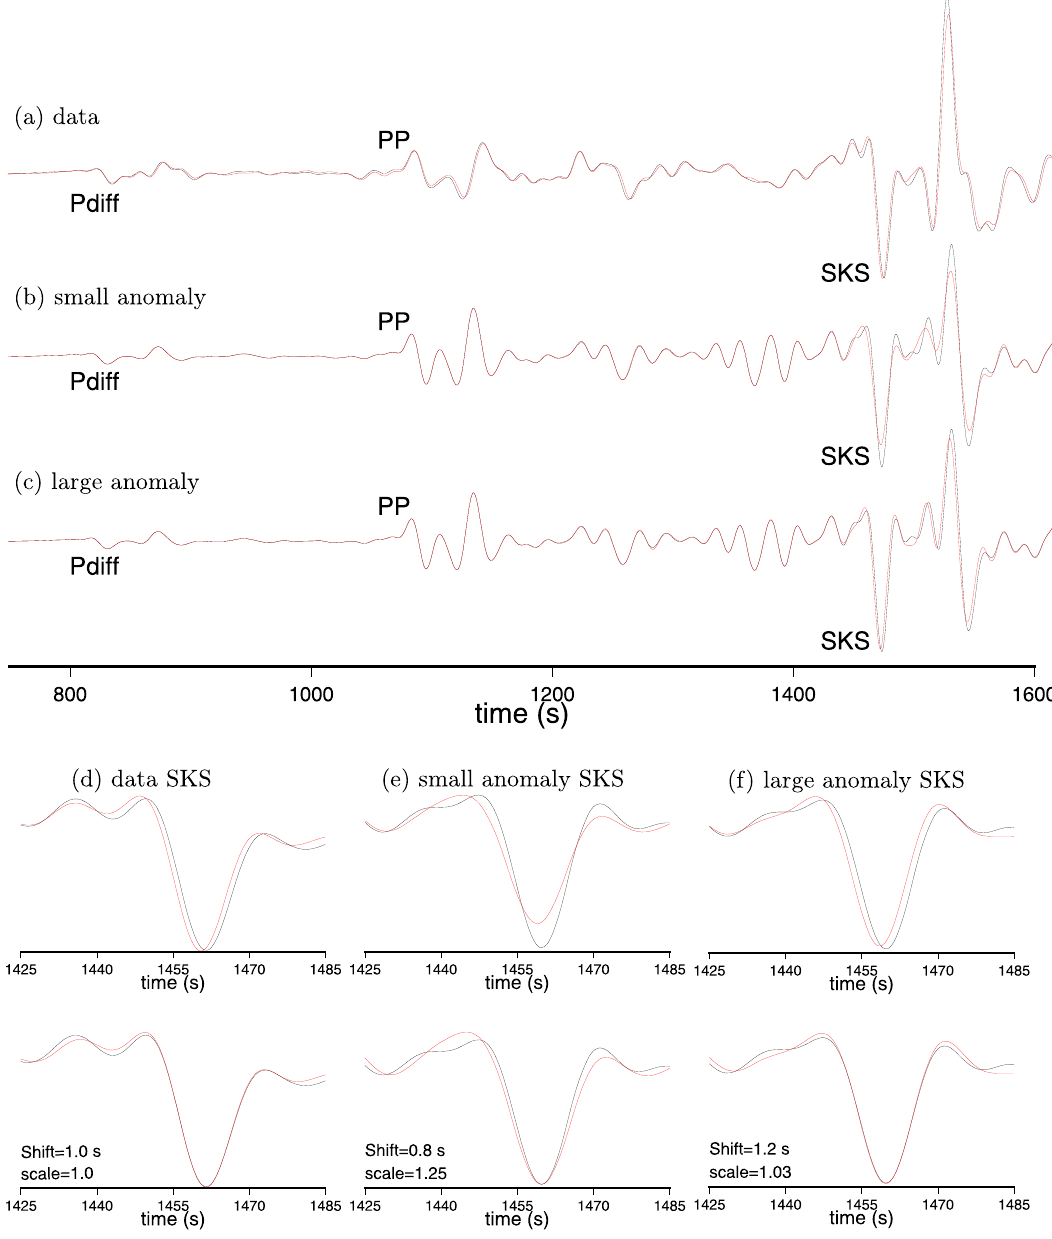
Fig. 6 SPECFEM seismograms calculated for different size core anomalies. a Observed seismograms at station ULN. A longer section of the original seismograms are plotted in Fig. S5. The SKS wave travels faster at the time of the second earthquake (red line). b and c are synthetic seismograms calculated for a small and a large anomaly in the outer core. d – f are zoom-in views of the SKS waves. The small anomaly has a radius of 6 ∘ and P-wavespeed increase of 4%; and the large anomaly has a radius of 12 ∘ and P-wavespeed increase of 1.5%, respectively. The locations of the anomalies are plotted in Fig. 5. The reference 1D model is PREM. It is worth noting that the observed data in ( a ) are for two different earthquakes with different focal depths, and therefore their depth phases have different arrivals. The synthetics in ( b ) and ( c ) are for two identical earthquakes, with the only difference being the P-wavespeed perturbations in the outer core. The purpose of this fi gure is to illustrate the effects of wave diffraction on SKS waveforms, not to model the complete seismograms from the two earthquakes which also depend on mantle structure. While a strong small anomaly and a large weak anomaly may produce the same amount of time shift on the SKS wave, the small anomaly introduces strong wave diffraction effects which result in smaller amplitude and broader waveform of the SKS